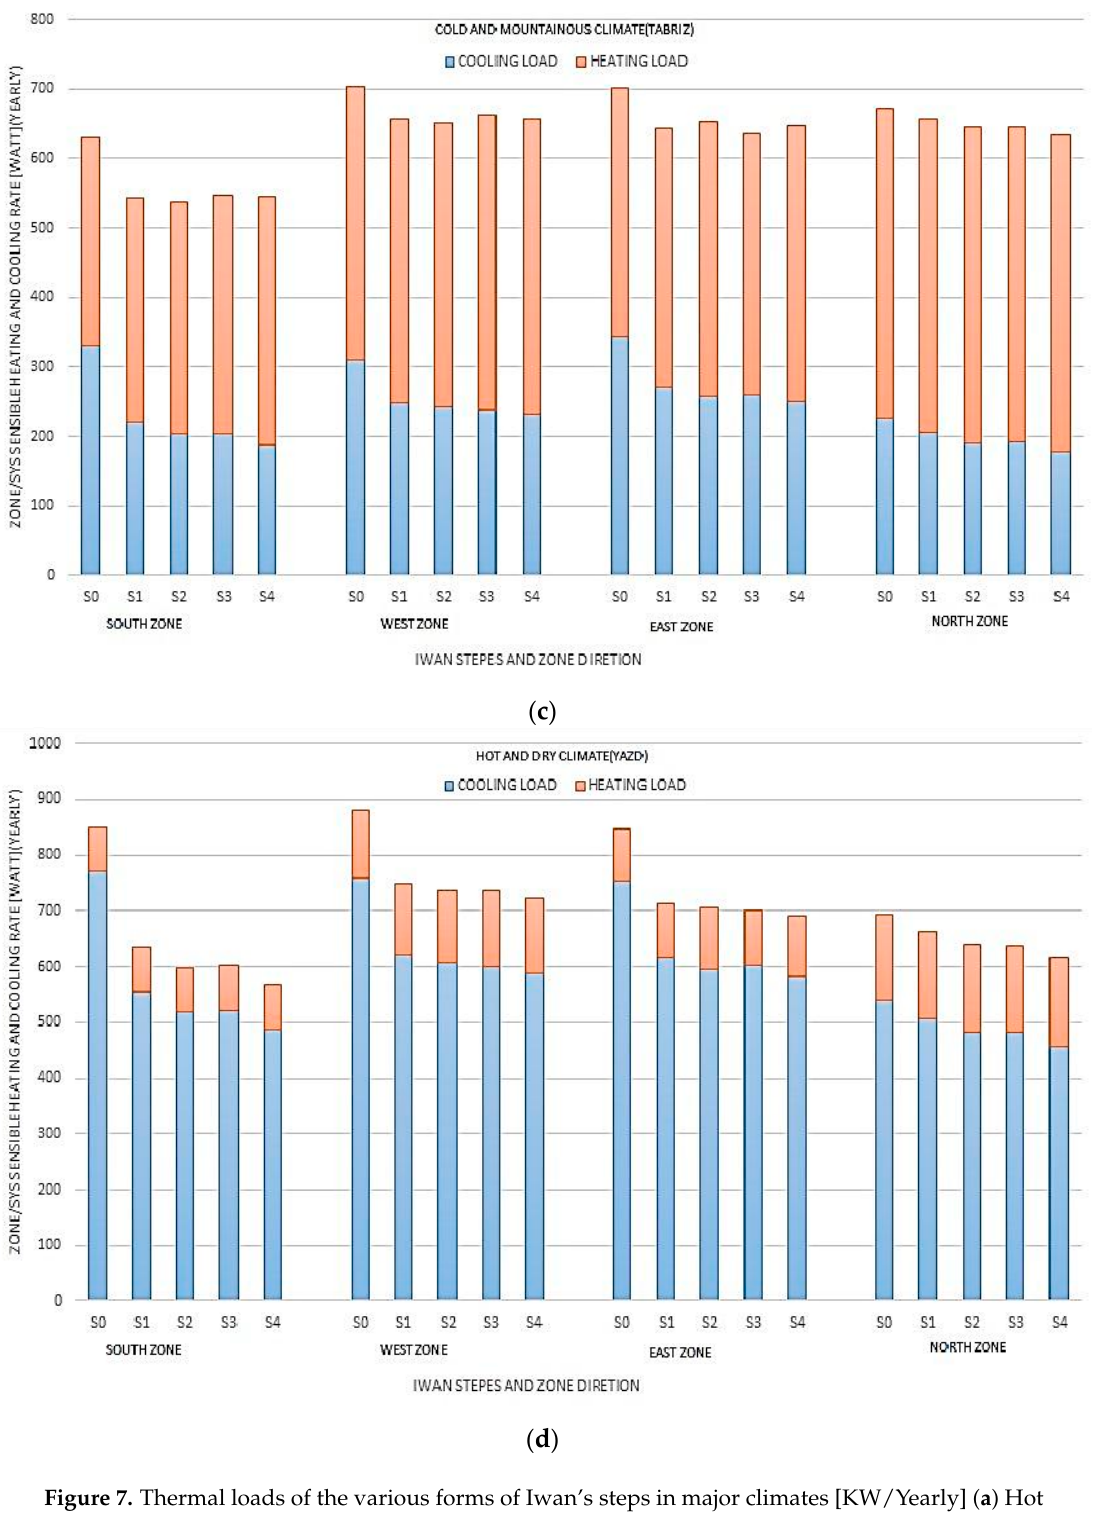
Figure 7. Thermal loads of the various forms of Iwan’s steps in major climates [KW/Yearly] ( a ) Hot and Humid (Bandar Abbas); ( b ) Temperate and Humid (Sari); ( c ) Cold and Mountainous (Tabriz); ( d ) Hot and Dry (Yazd).